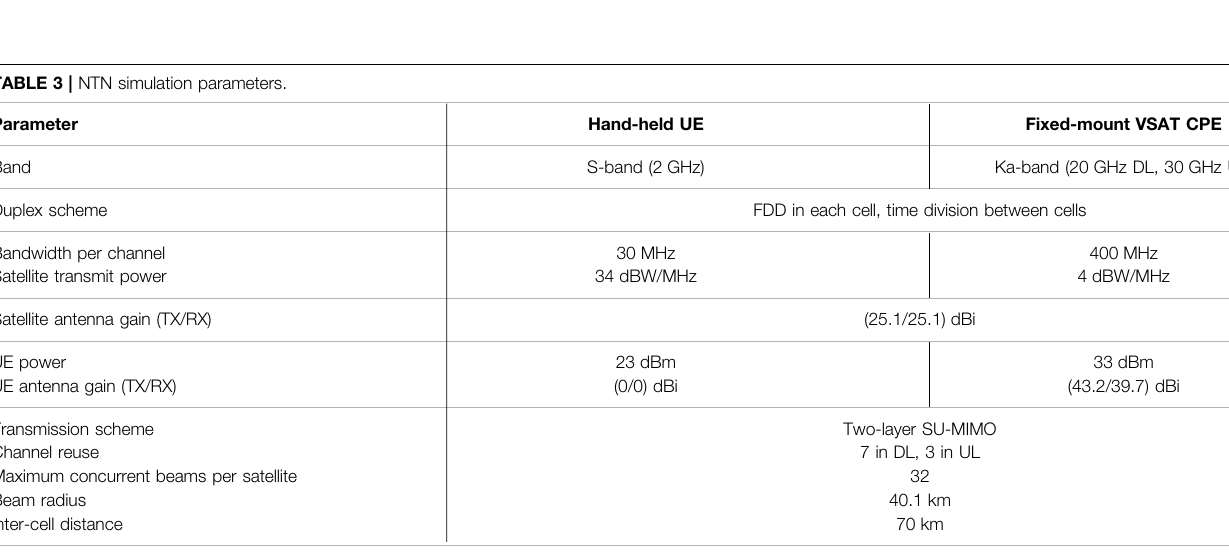
TABLE 3 | NTN simulation